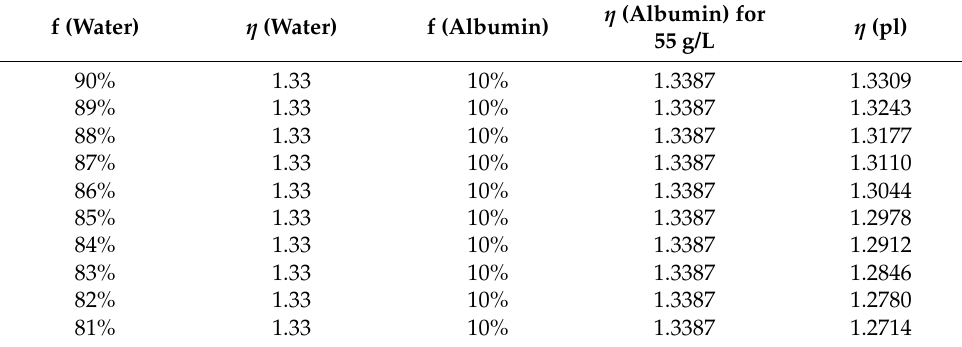
Figure 6. Normalized output power of the design structure. Table 3. Water concentration in blood and refractive index of plasma.